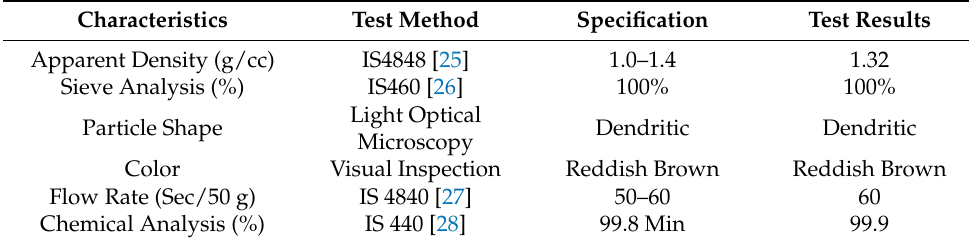
Table 1. Properties of copper particles.